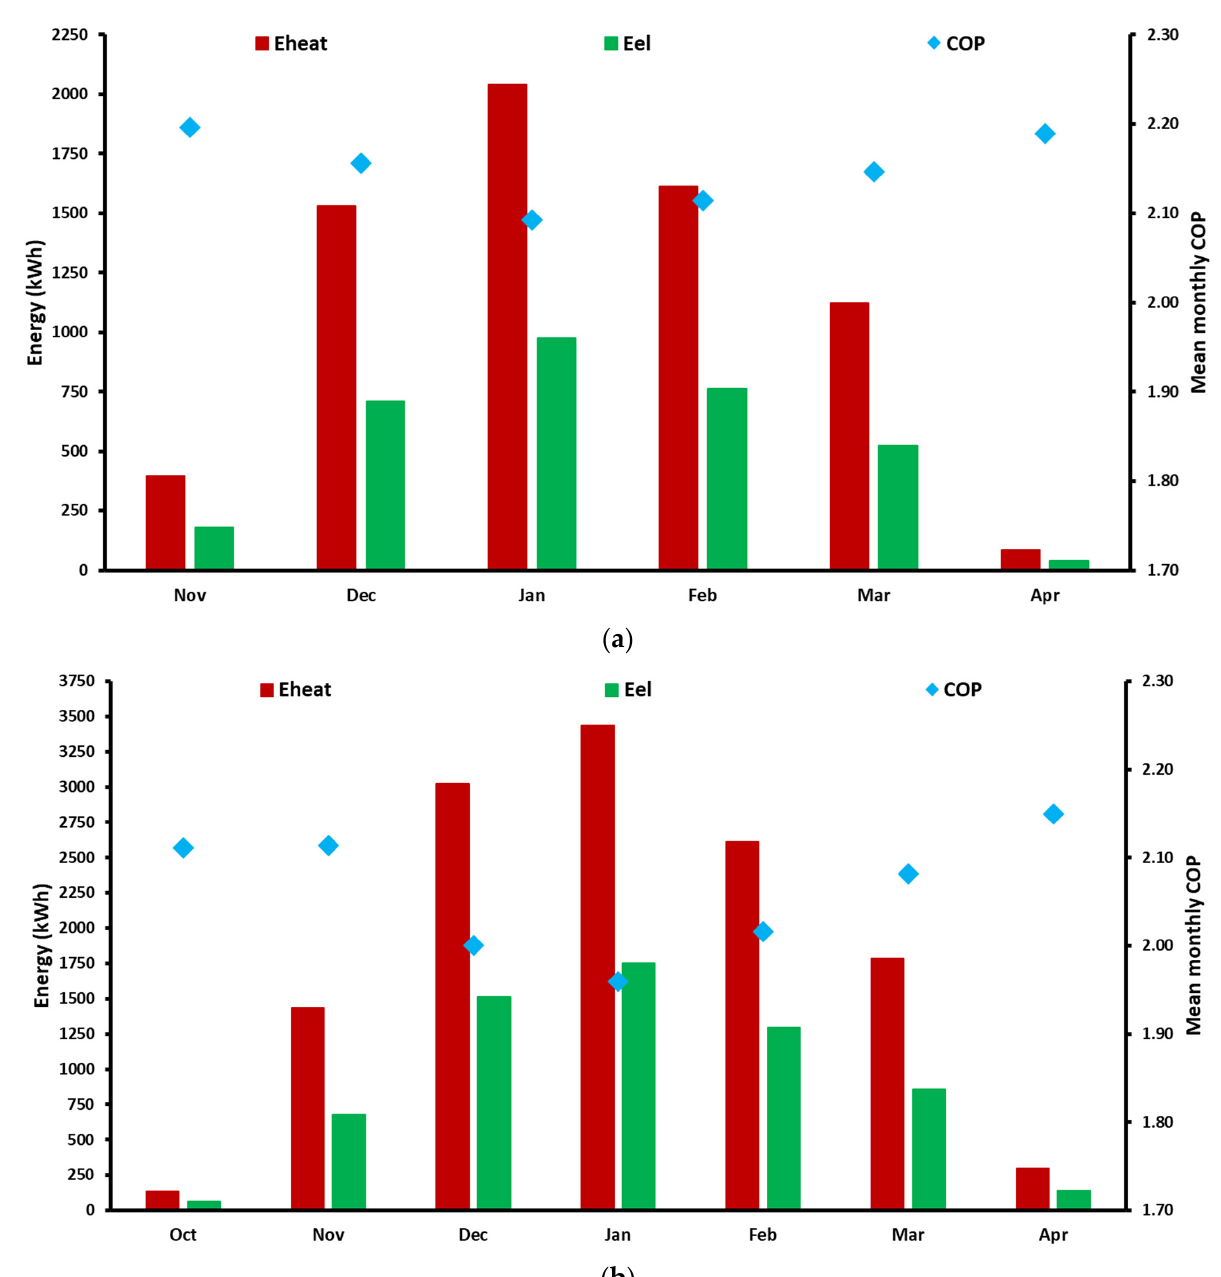
Figure 12. Heat pump system: monthly energy quantities [kWh] and mean COP for ( a ) Athens (Zone B), and ( b ) Thessaloniki (Zone C).